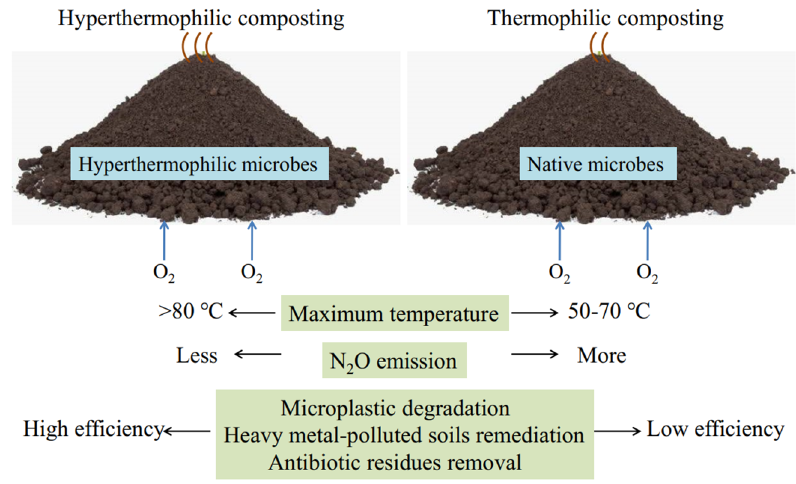
Figure 5. Comparison of operation conditions and performances between HTC and TC.